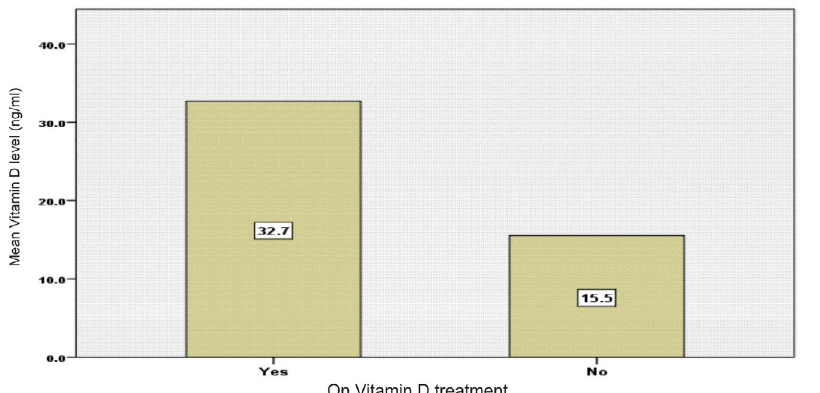
Fig. 1. Mean 25-hydroxyvitamin D3 level in patients with multiple sclerosis according to presence or absence of vitamin D treatment (supplements).